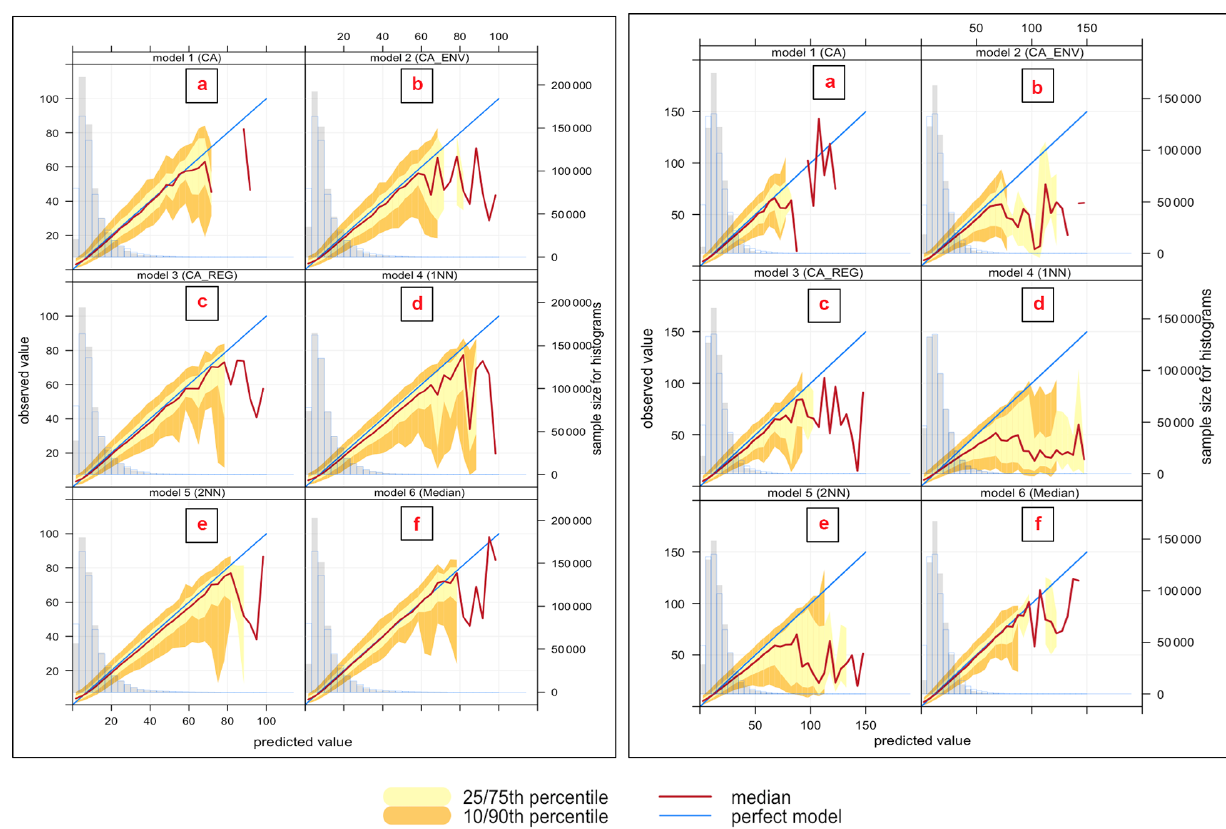
Figure 3. Conditional quantile plot of modelled and observed pollutant concentrations of PM 2 . 5 (left plot) and PM 10 (right plot) for proposed